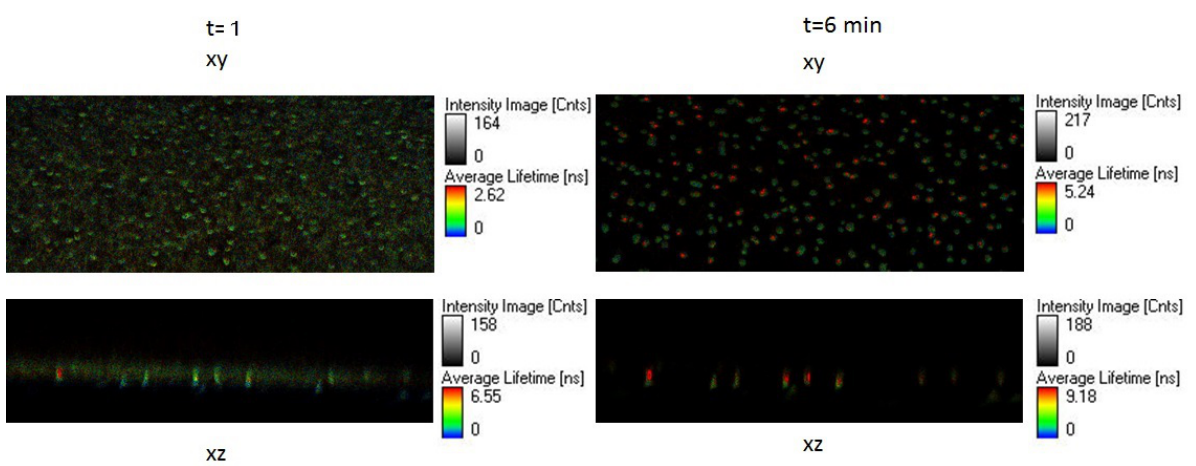
Figure 7: Fluorescent lifetime image microscopy (FLIM) in xy (top) and xz (bottom) scanning mode, accumulating photons for t = 1 and t = 6 min. The horizontal size is 60 µ m. The color scales with the luminescence lifetime while the intensity scales with photon counts. At t = 1 the lifetime (a few ns) distribution is spatially more uniform and more intense than at t = 6 min.